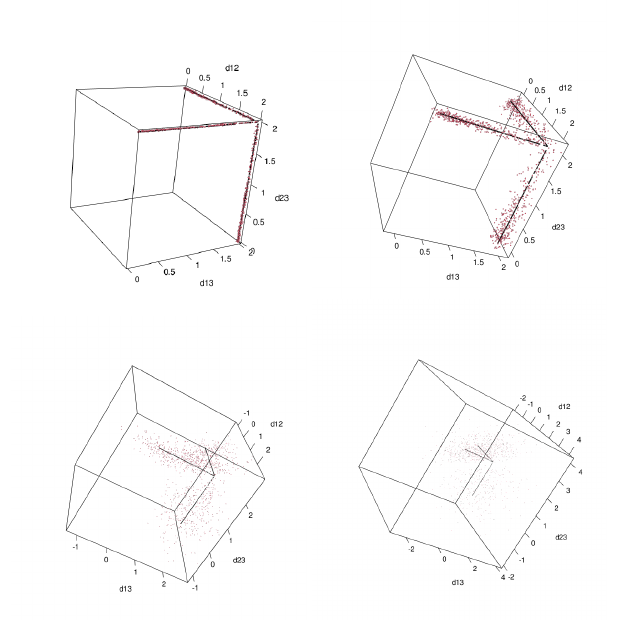
Figure 5. Red points are randomly generated δ = ( δ 12 , δ 13 , δ 23 ) and black points are ultrametrics which are equivalent to equidistant trees. The top left figure is for σ = 0.01. The top right figure is for σ = 0.1. The bottom left figure is for σ = 0.5. The bottom right figure is for σ = 1.